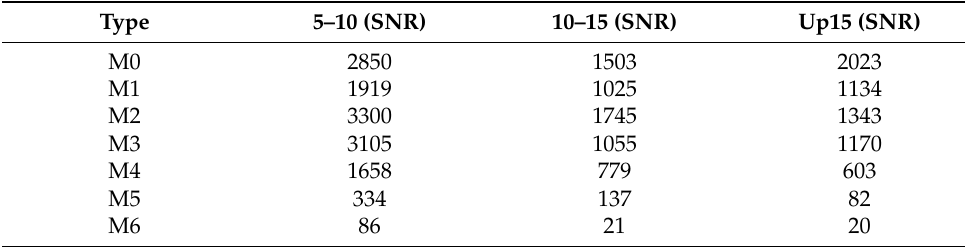
Table 2. Number of the experimental